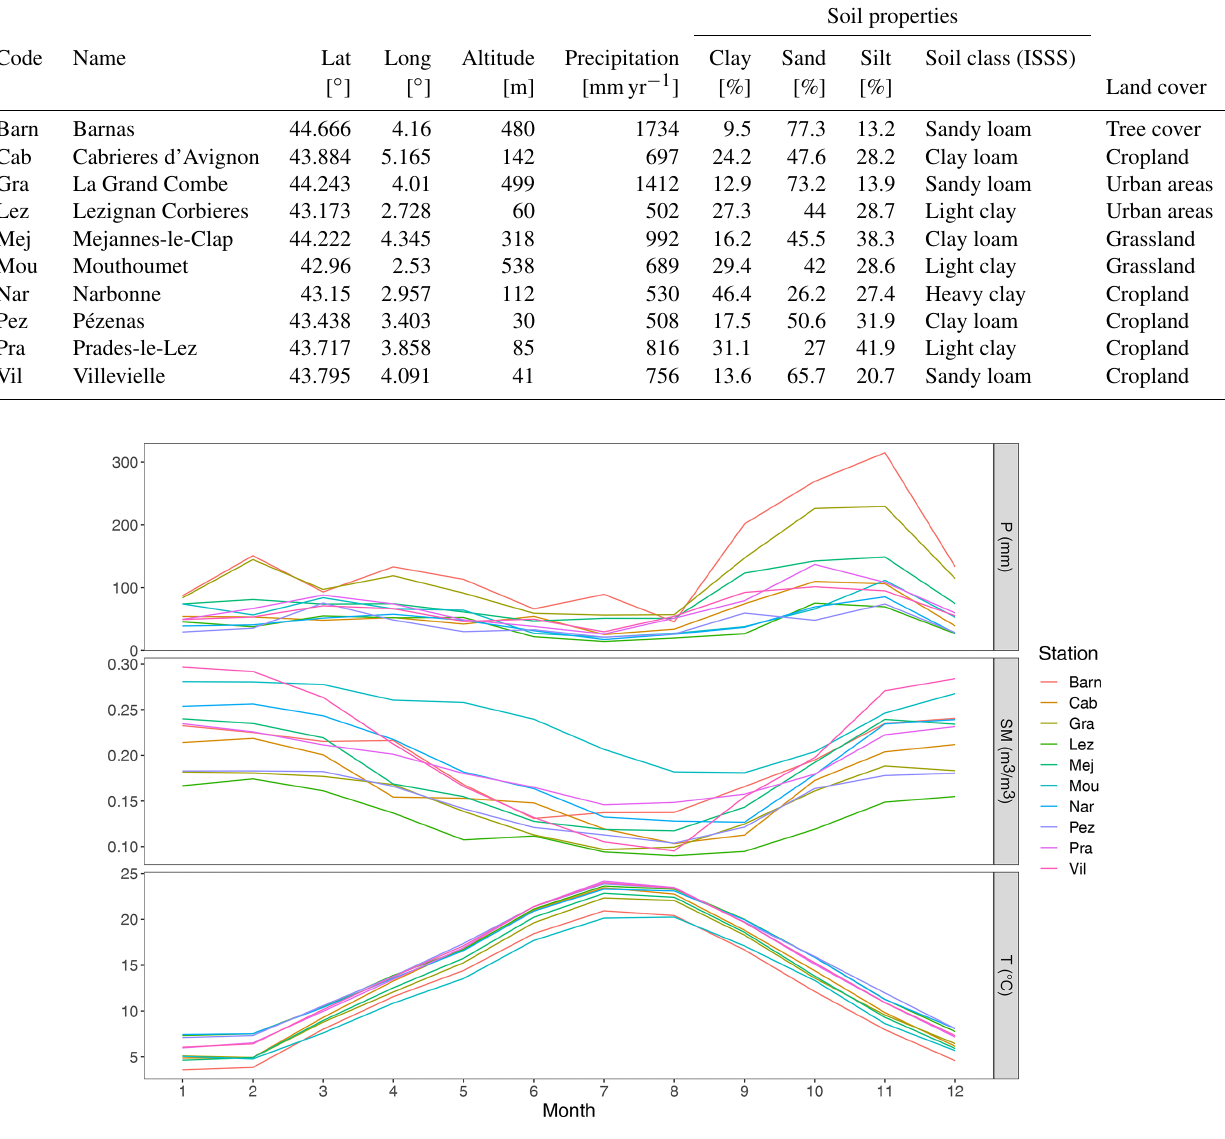
Figure 2. Observed seasonal cycle of precipitation, soil moisture, and air temperature at the stations.